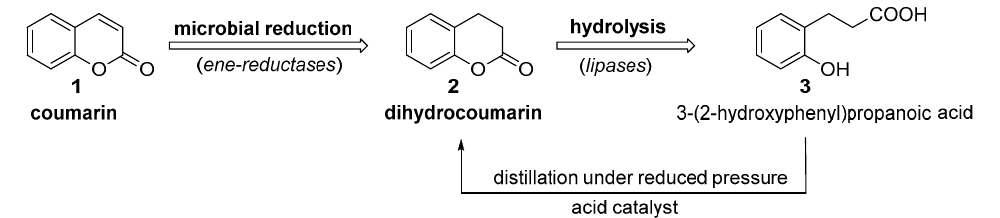
Figure 2. The biocatalysed process for the preparation of natural dihydrocoumarin starting from natural coumarin.